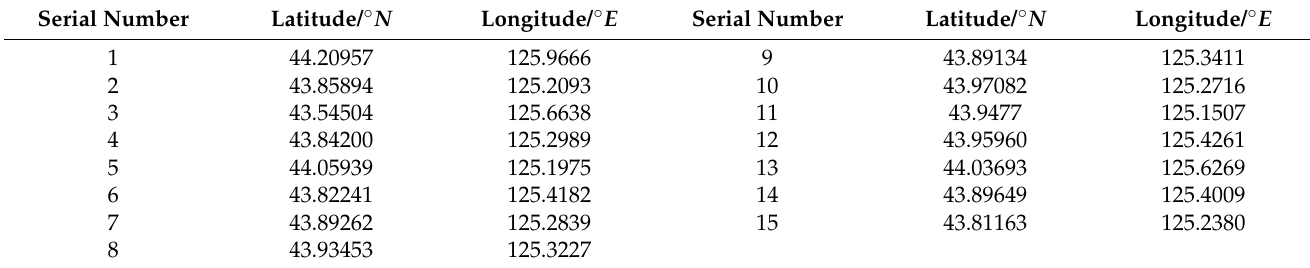
Figure 11. Schematic diagram of the location of the candidate nodes, paper mill, and landfill .